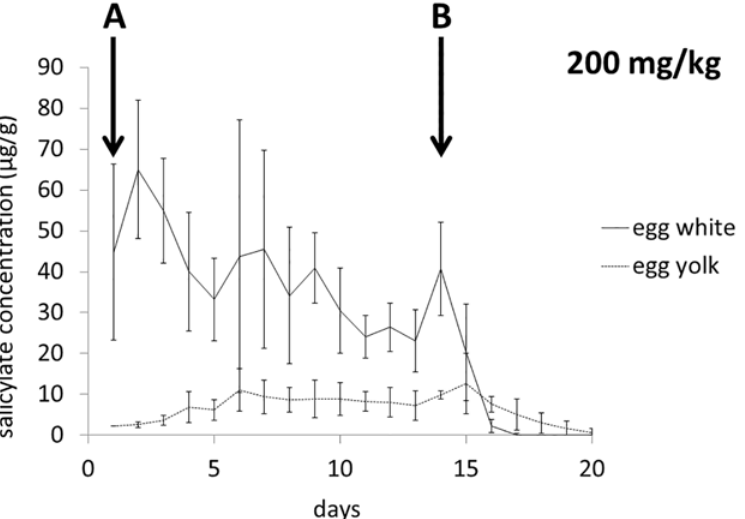
Fig 3. Time-dependent changes in egg white and yolk salicylate (SA) concentrations in the higher dose group (200 mg/kg). Letter (A) indicates the onset of daily sodium salicylate (SS) administration and letter (B) points the last SS